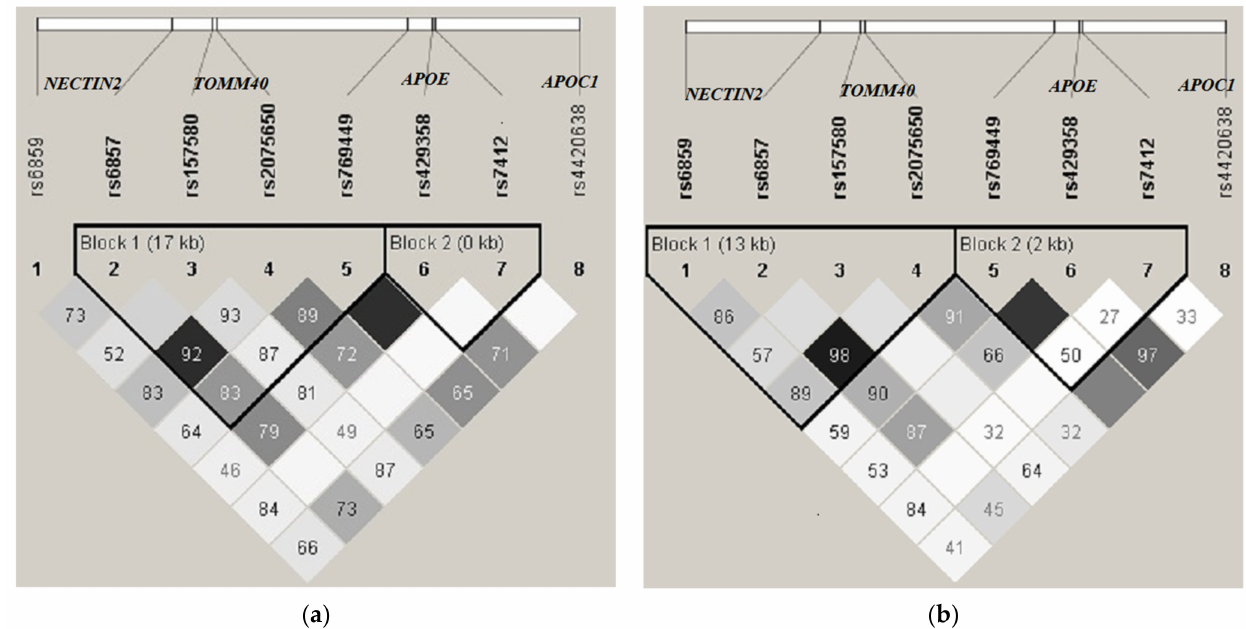
Figure 1. The structure of linkage disequilibrium in the genomic region of the NECTIN2-TOMM40-APOE locus: ( a ) tThe structure of LD for the cases; ( b ) the structure of LD for the controls. Linkage disequilibrium was measured by the D’ statistic: black—a strong link (D’ = 1, LOD > 2), grey—a significant link (D’ < 1, LOD > 2), white—poor link (D’ < 1, LOD < 2). A D’ value of 100 indicates a complete LD between 2